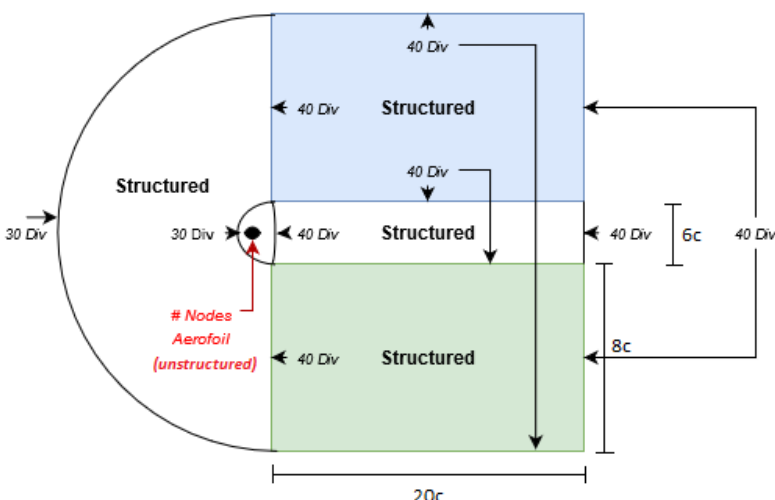
Figure 4. Topology of the C-type mesh used in the aerodynamic simulations.